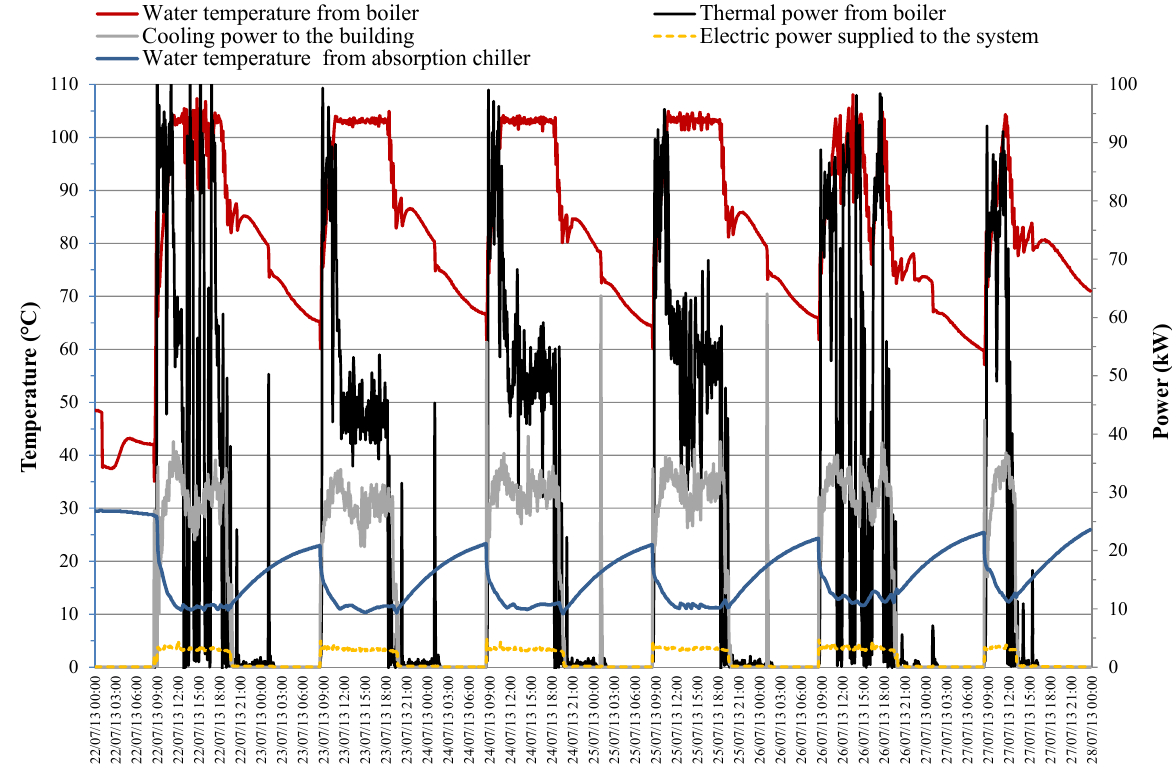
Figure 8. Weekly cooling working cycle of biomass boiler and absorption machine: the thermal power produced by the boiler, cooling power for the building, and the electric power absorbed by the system are